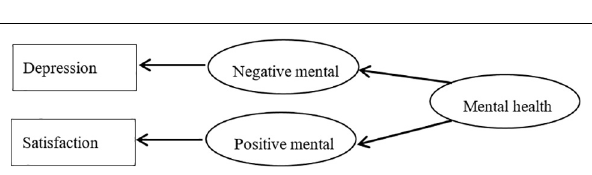
FIGURE 1 | Flourishing-depression of dual-factor model of mental health.